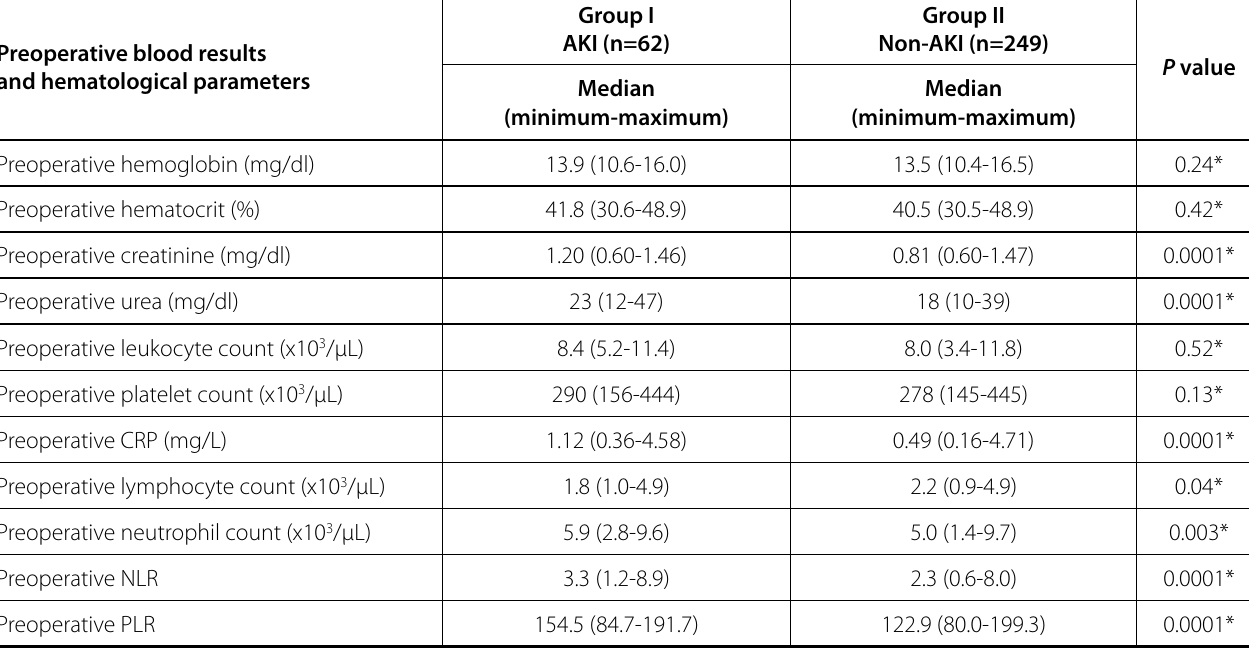
Table 2. Preoperative blood results and hematological parameters of patients.